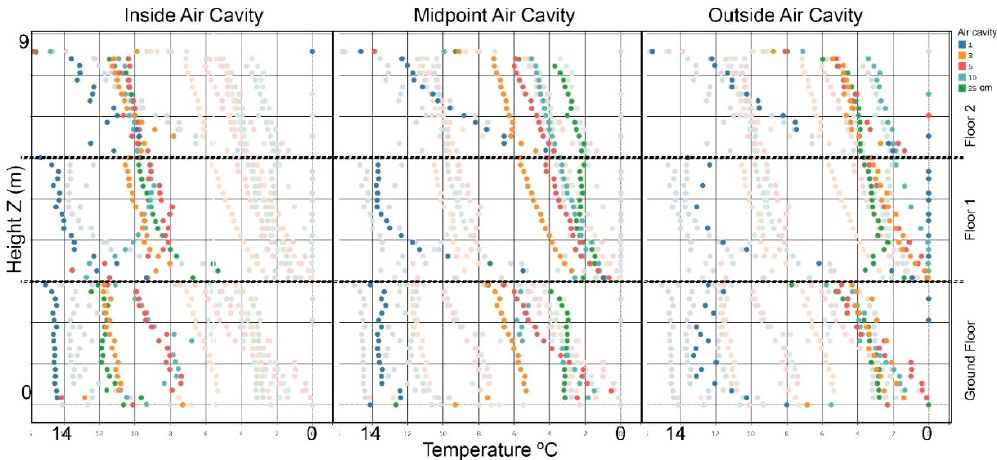
Figure 9. Temperatures reached inside the air chamber depending on its thickness.